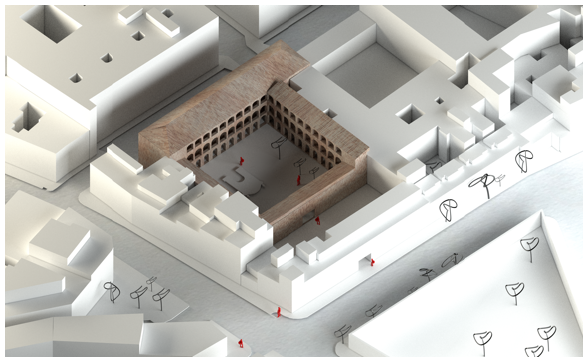
Figure 12. Detailed scale. The restrictions on access to